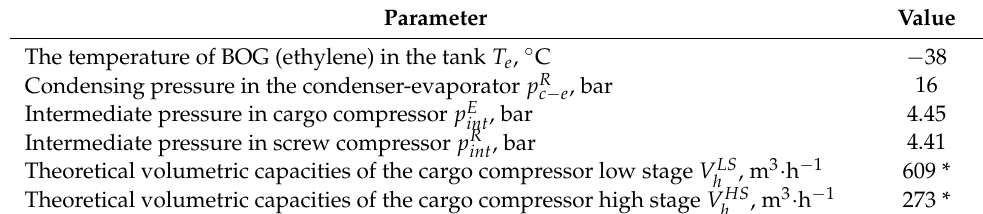
Figure 4. The thermodynamic cycle of the reliquefaction system in the T – s diagram. Table 1. Initial data.